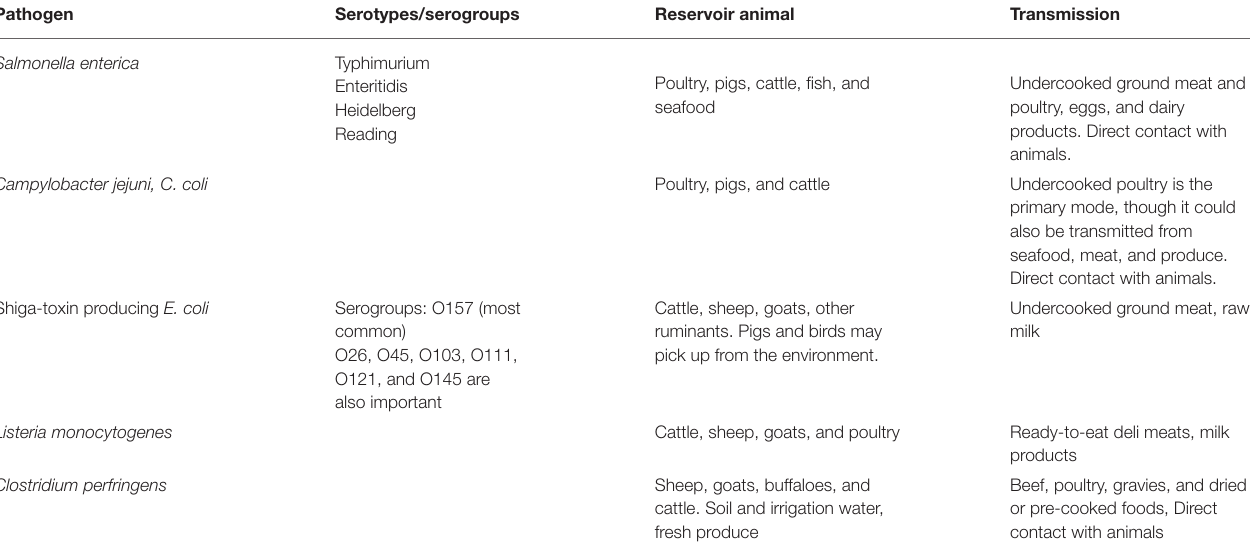
TABLE 1 | Pathogens involved in foodborne outbreaks and their modes of transmission.